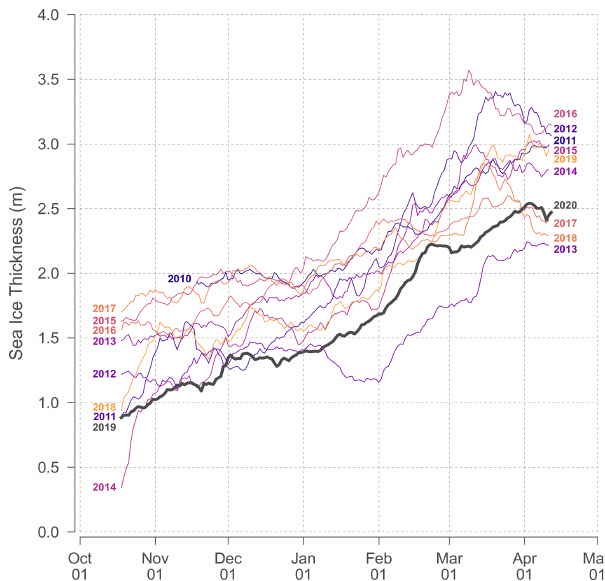
Figure 13. Daily sea ice thickness from gridded CryoSat-2/SMOS (CS2SMOS) multi-sensor thickness analysis extracted within 50km of the CO noon position for all Arctic winters in the CS2SMOS data record. Each winter season is marked by the start and end year, e.g. 2011–2012. The bold black line indicates data during the MOSAiC year and is identical to the 50km radius CS2SMOS data in Fig.